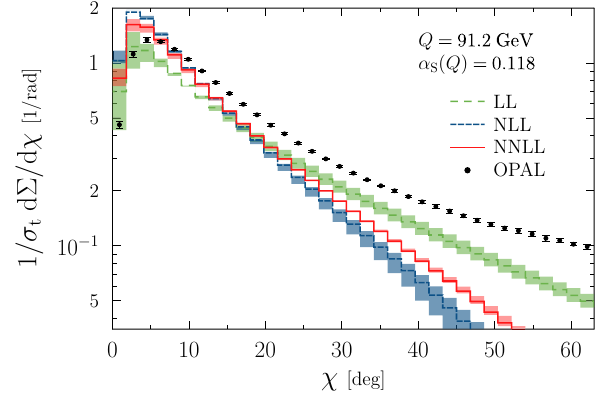
Fig. 2 Purely resummed predictions for EEC at LL, NLL and NNLL accuracy.Thebandsrepresenttheeffectsofvaryingtherenormalization scale by a factor of two around the default scale of μ = Q . OPAL data is also